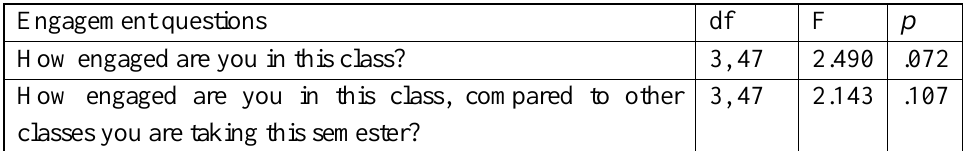
Table 3 ANOVA Results for Follow-Up Engagement Questions Engagement questions